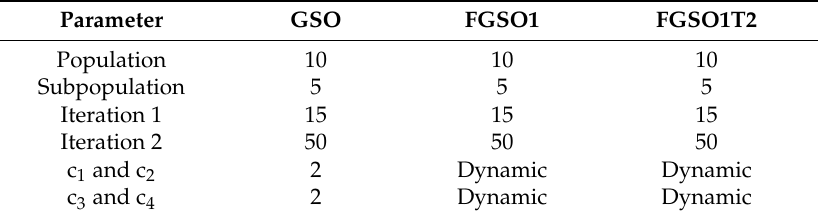
Table 1. Parameters for the optimization in GSO, FGSO1 and FGSO1T2.